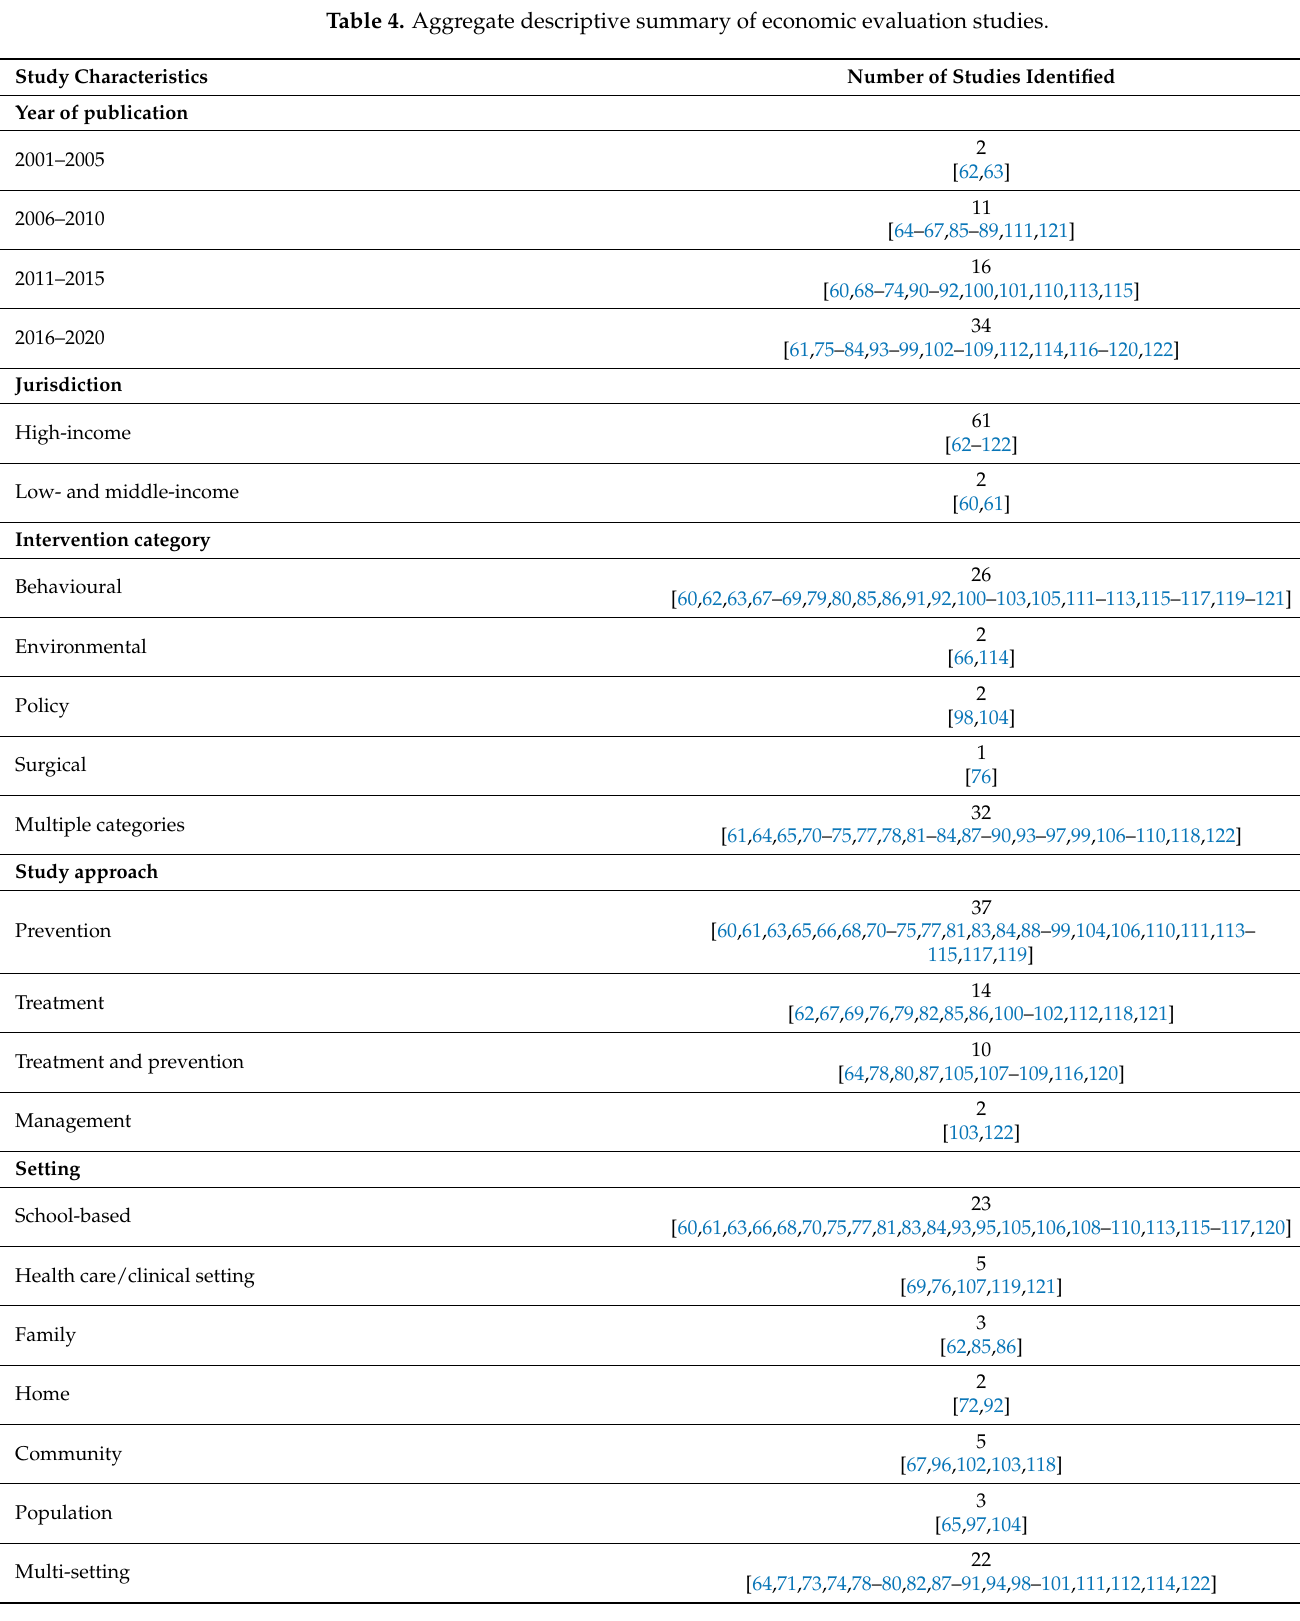
Table 4. Aggregate descriptive summary of economic evaluation